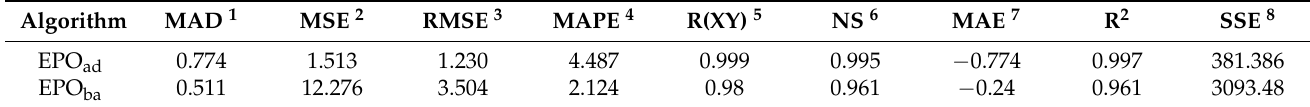
Table 1. Validation results of EPO ba and EPO ad in simulating the SOP.